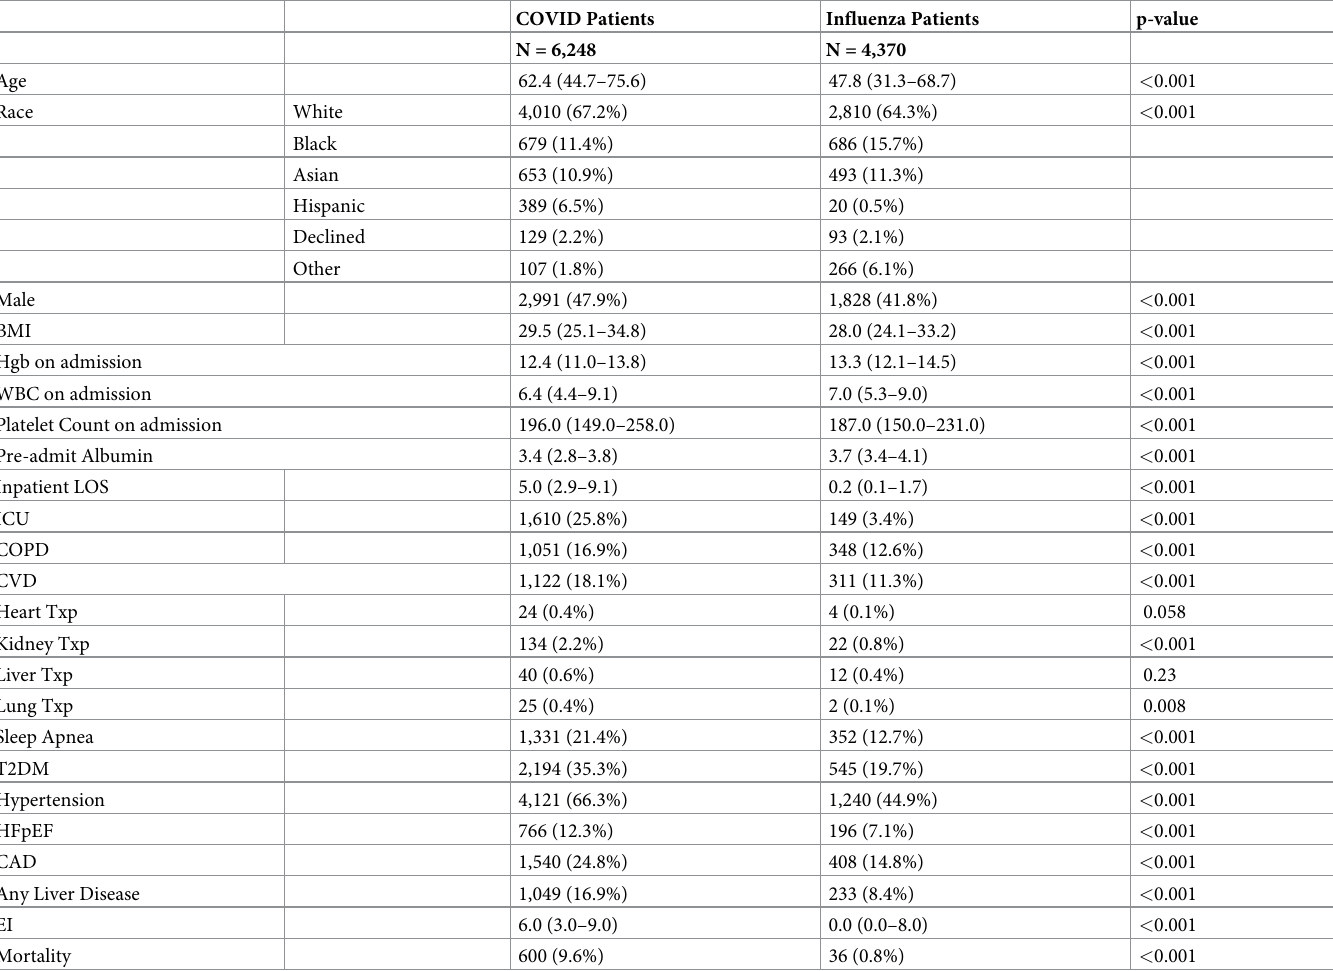
Table 6. Descriptive Table: Comparison of the SARS-CoV-2 to influenza patients admitted to hospital. Categorical variables expressed as count and percent, and con- tinuous variables as median and IQR.